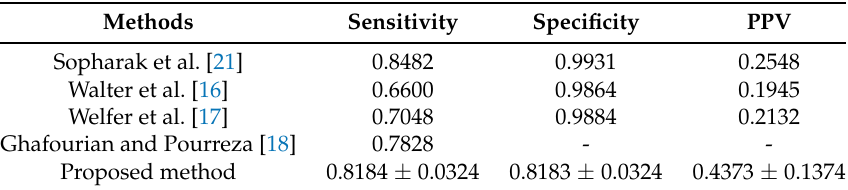
Table 7. Comparison of exudate detection methods for the 47 retinal images with exudates of DIARETDB1